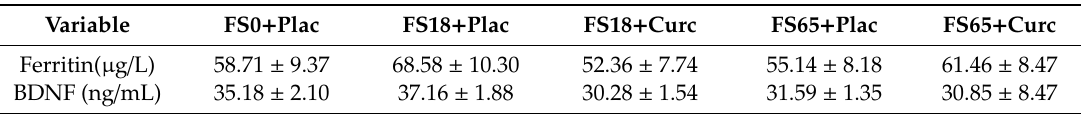
Table 2. Participant baseline ferritin and brain-derived neurotrophic factor (BDNF) levels expressed as mean ±